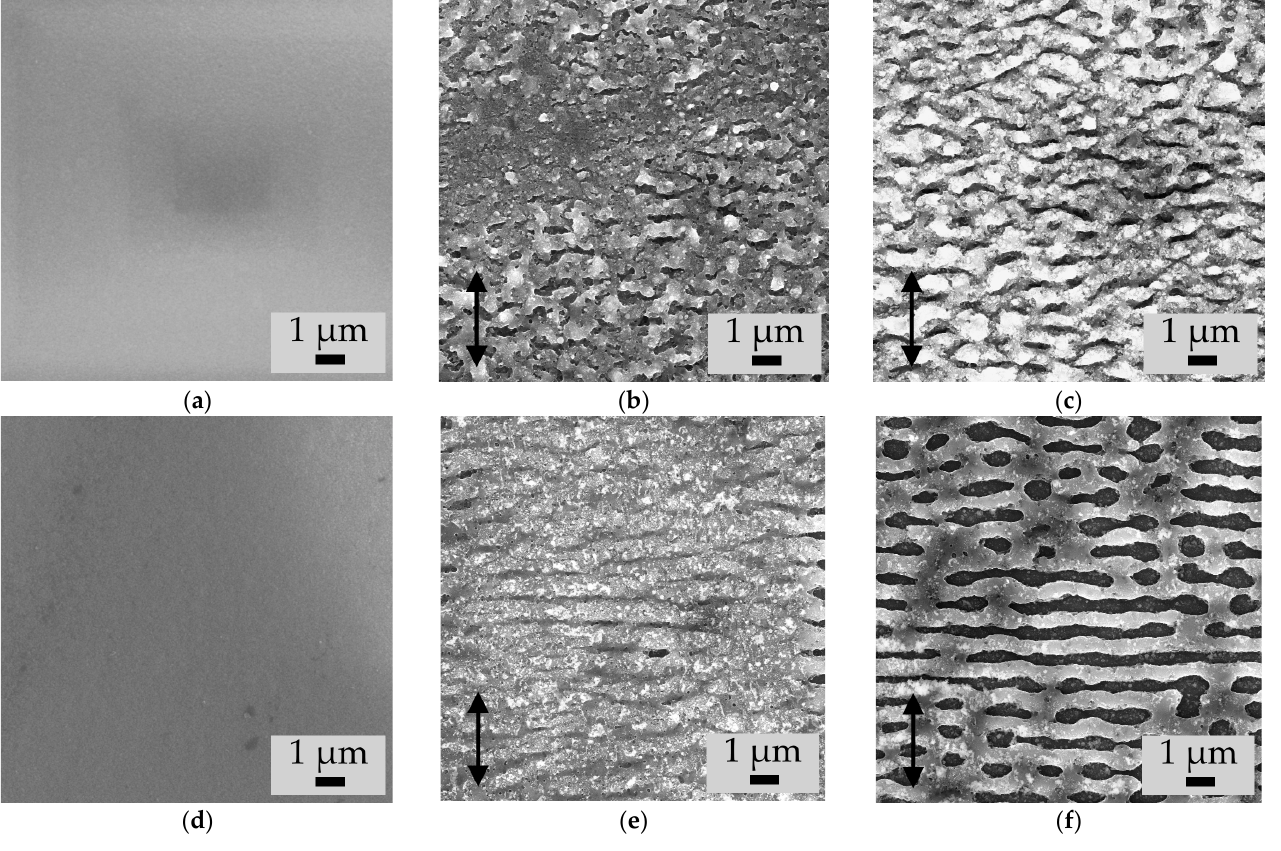
Figure 4. SEM images of the surfaces of ( a ) initial p-a-Si; femtosecond laser-irradiated samples ( b ) P1, ( c ) P2; ( d ) initial n-a-Si; femtosecond laser-irradiated samples ( e ) N1 and ( f ) N2. The direction of laser polarization is indicated by an arrow on the images.